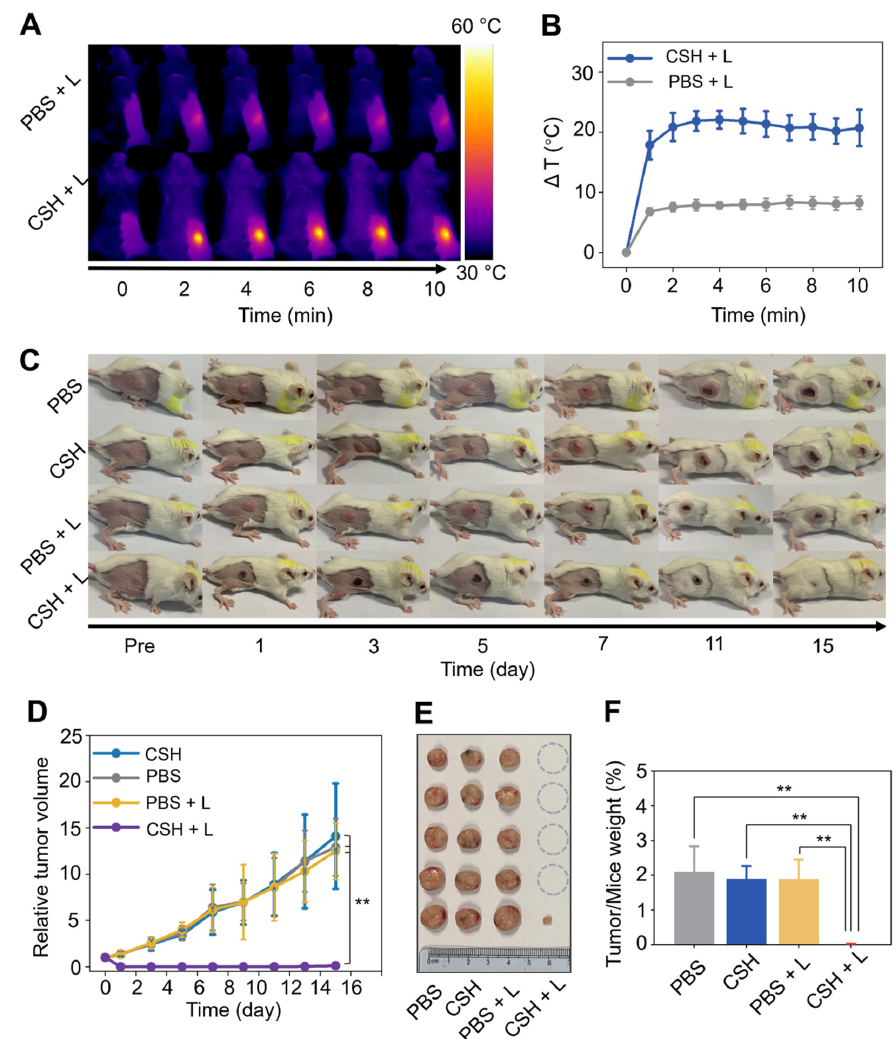
Figure 6. ( A ) Thermal images of tumor-bearing mice treated with only PBS or both CSH and NIR-II laser irradiation. ( B ) Photothermal heating curves of tumor sites taken with an infrared thermal camera. ( C ) Tumor-monitoring photography of mice in various groups. ( D ) Relative tumor volume curves of mice in different groups ( n = 5 in each group, ** p < 0.01). ( E ) Excised tumors from the mice on the 15th day of the observation period. ( F ) Ratio of final tumor weight to final body weight of mice in different groups (** p < 0.01).